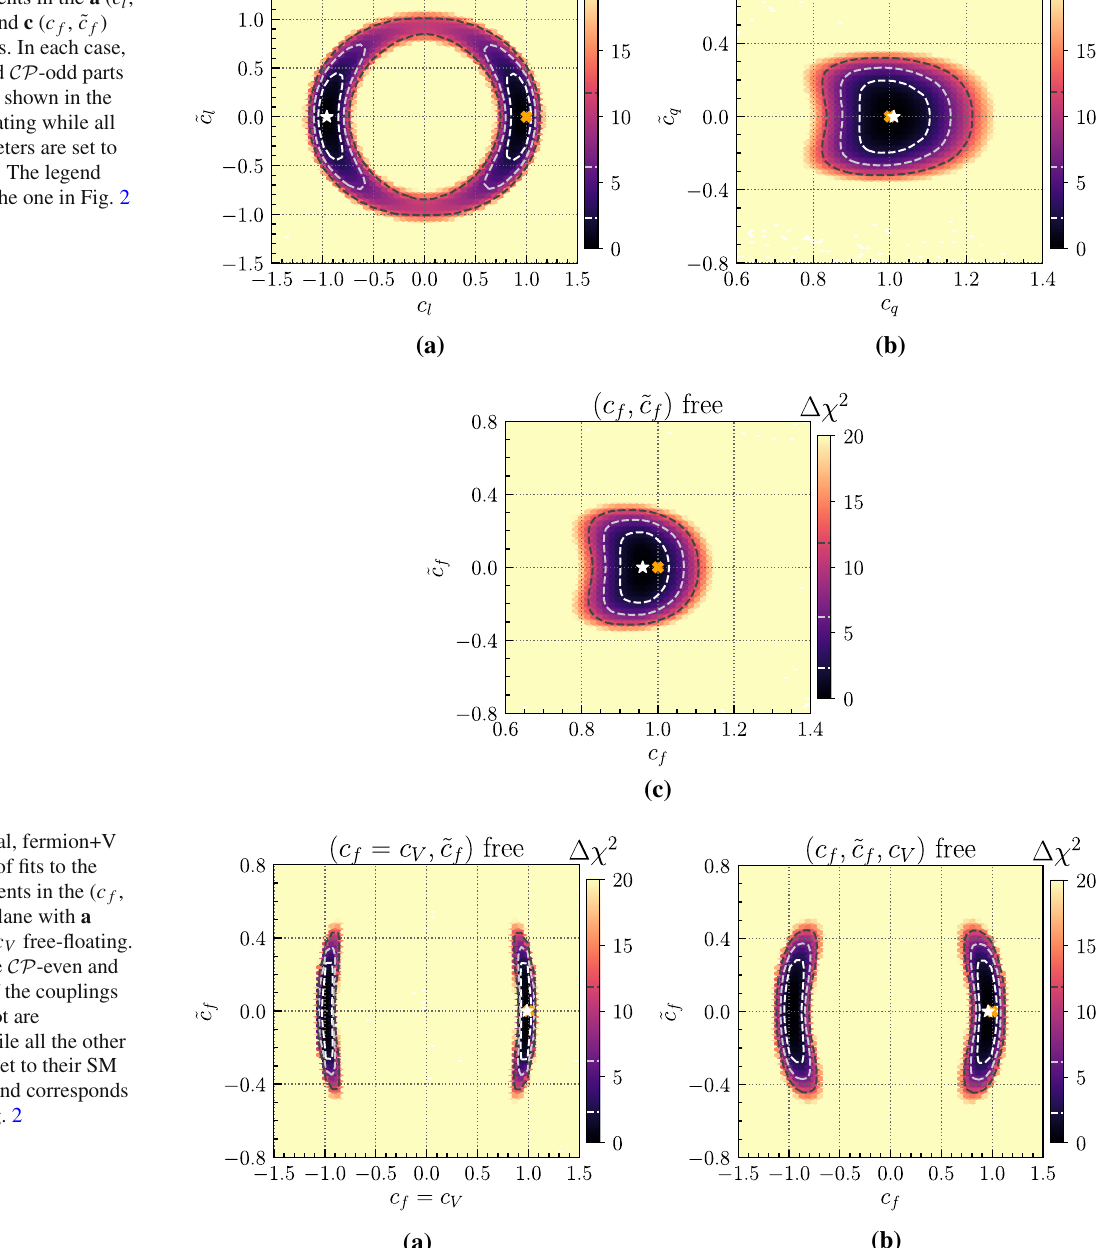
Fig. 6 Lepton, quark, fermion models: results of fits to the LHC measurements in the a ( c l , ˜ c ˜ c ˜ c l ), b ( c q , q ), and c ( c f , f ) parameter planes. In each case, the CP -even and CP -odd parts of the couplings shown in the plot are free-floating while all the other parameters are set to their SM values. The legend corresponds to the one in Fig. 2